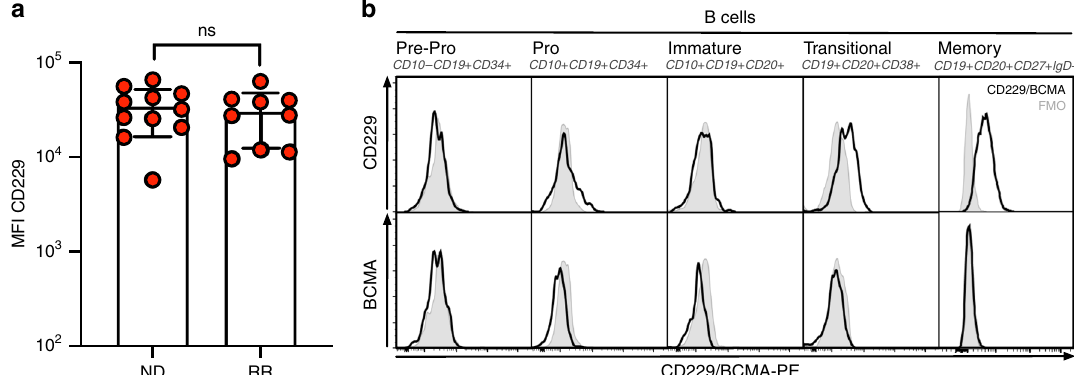
Fig. 1 CD229 expression on MM plasma cells and B lineage cells. a Expression of CD229 on CD38 + CD138 + plasma cells in the bone marrow from 20 patients with MM as determined by fl ow cytometry after staining with HLy9.1.25. Data represent mean ± SD. ND newly diagnosed, RR relapsed/refractory. Statistical signi fi cance was determined by two-sided Student ’ s t- test. b Expression of CD229 and BCMA on B cell populations in the bone marrow of a patient with MM as determined by fl ow cytometry. FMO fl uorescence minus one. Source data are provided as a Source Data fi